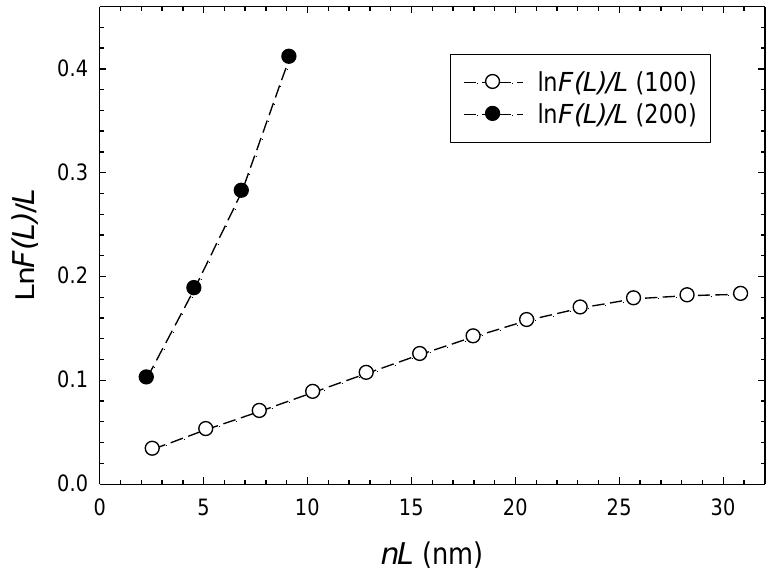
Figure 6. Warren–Averbach plot of the (100) and (200) reflections.